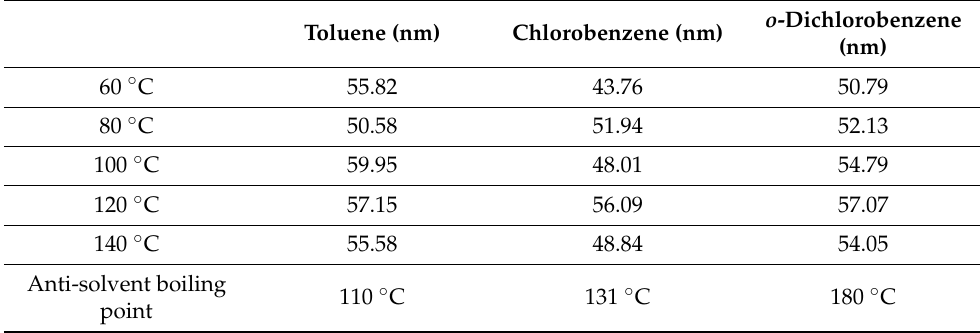
Table 1. Grain sizes produced by different anti-solvents and annealing